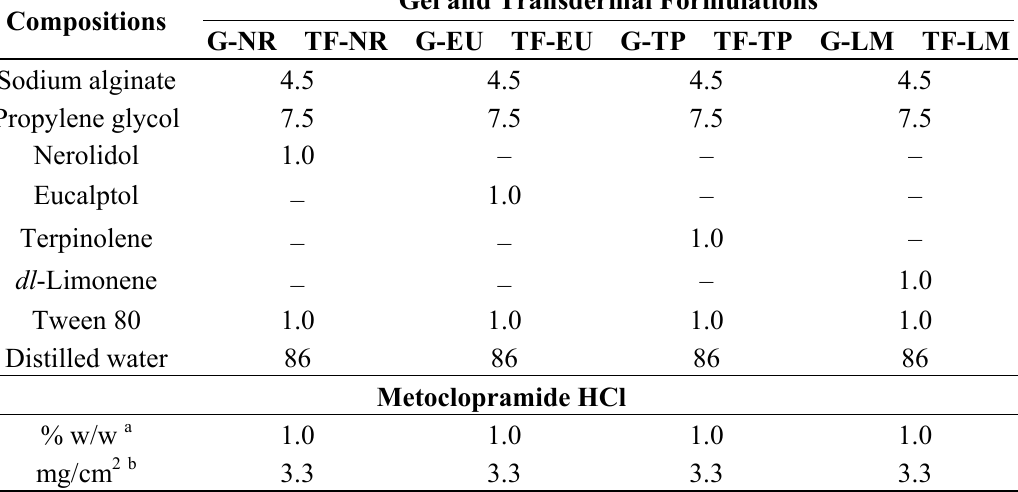
Table 1. The codes and composition of gel formulations (G) and transdermal films (TF) of metoclopramide hydrochloride (MTC) prepared from the gel formulations (w/w, % on wet